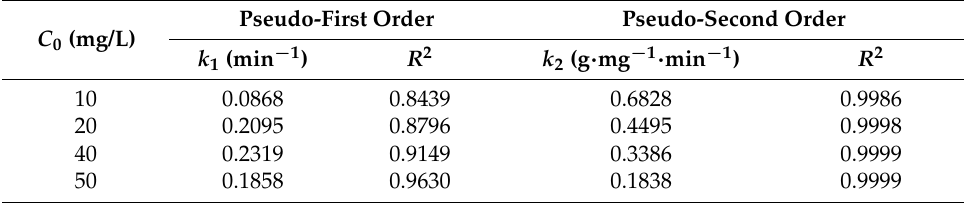
Table 1. Kinetic parameters of the adsorption data of BPA on Fe 3 O 4 @CTS/SiO 2 -C 12 composite. Pseudo-First Order C 0 (mg/L)